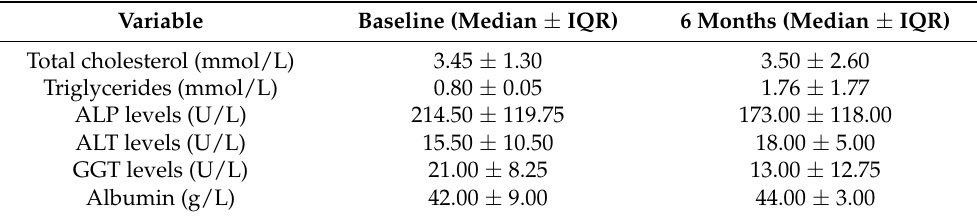
Table 2. Biochemical data of study patients on cKD at baseline and after 6 months (*data recorded only 10 patients because of the 14 patients drop out).